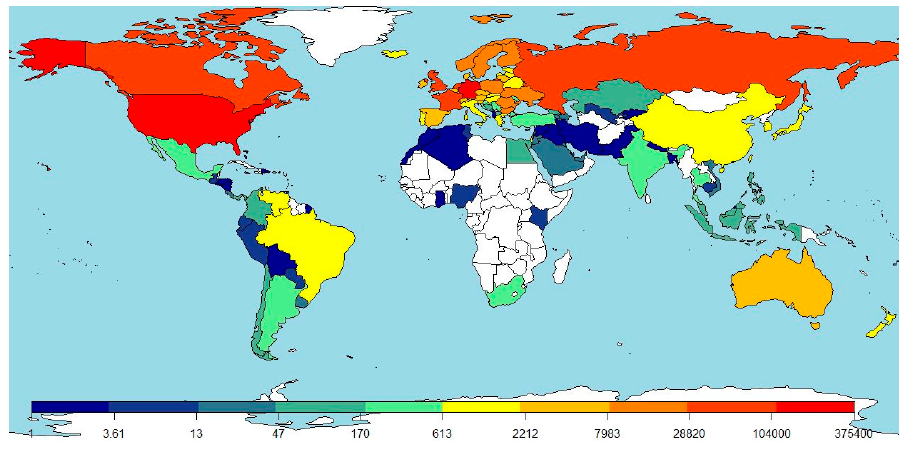
Figure 14. Transaction Volume in BTC (in Thousands) per Country.